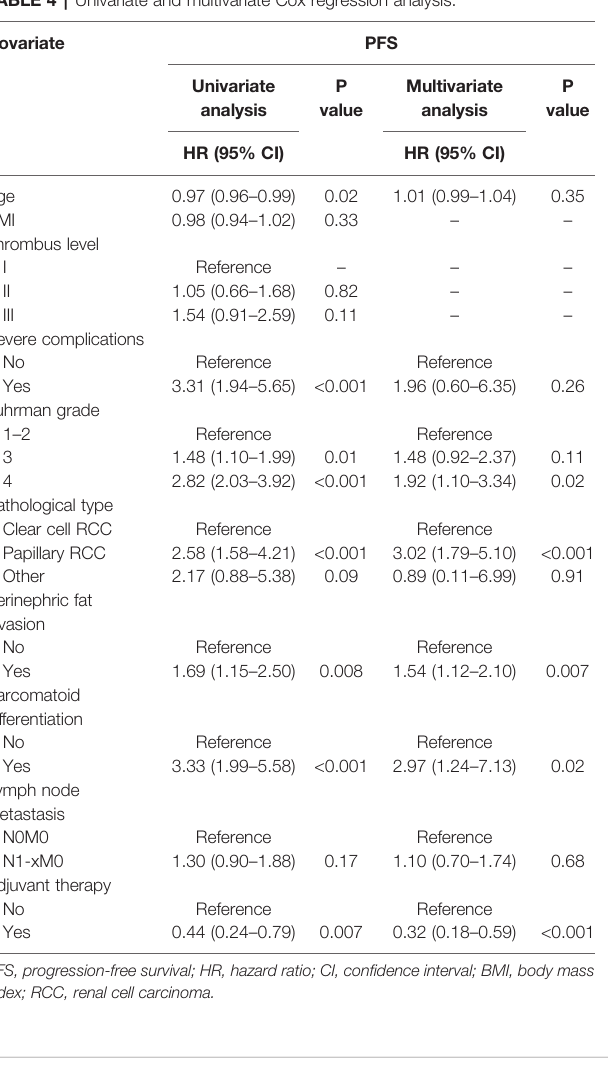
TABLE 4 | Univariate and multivariate Cox regression analysis.